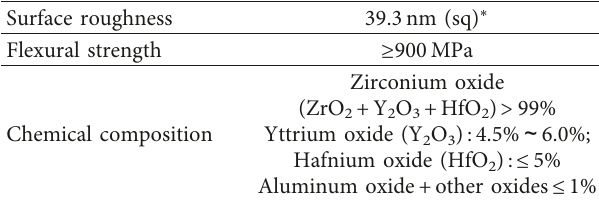
Table 2: Characteristics of the monolithic zirconia